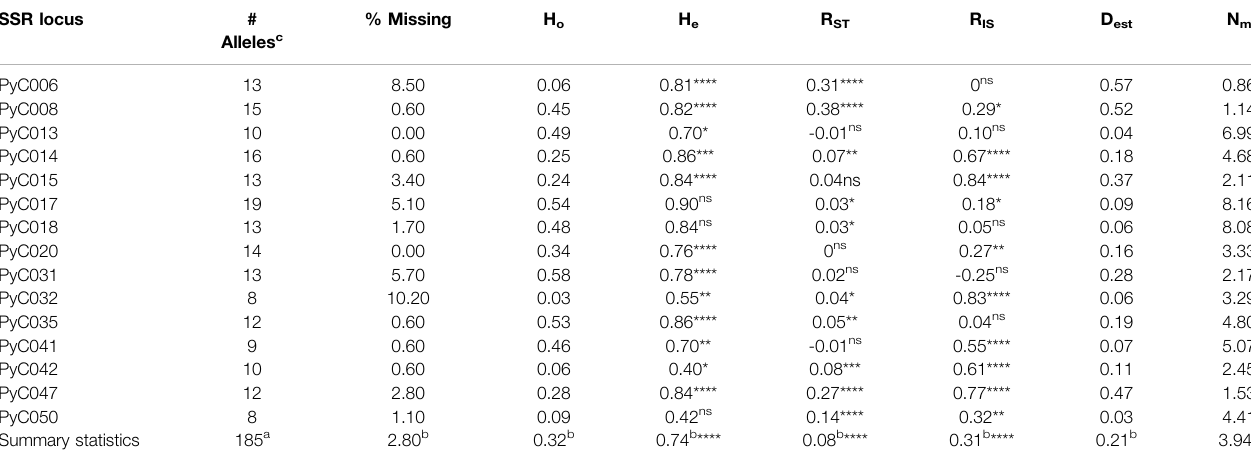
TABLE 2 | Genetic diversity indices for six subpopulations of trees genotyped in the Pyrus calleryana dataset based on molecular data using fi fteen microsatellite loci. SSR